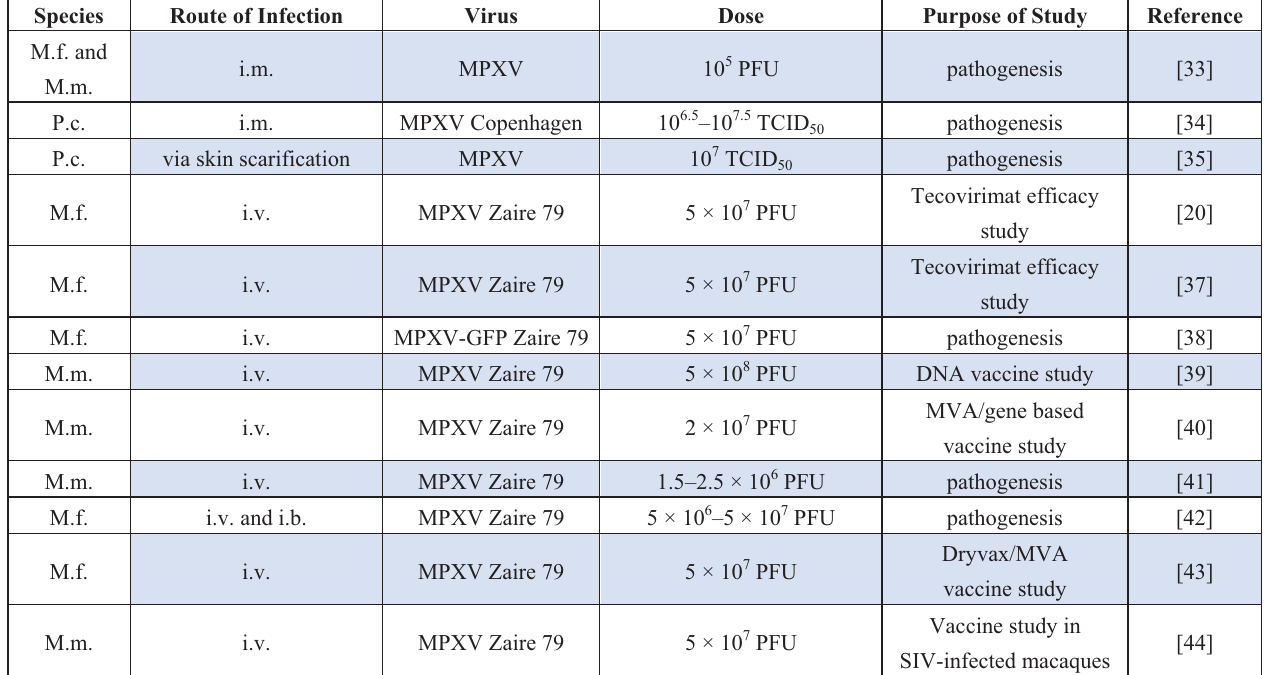
Table 1. Orthopoxvirus models in non-human